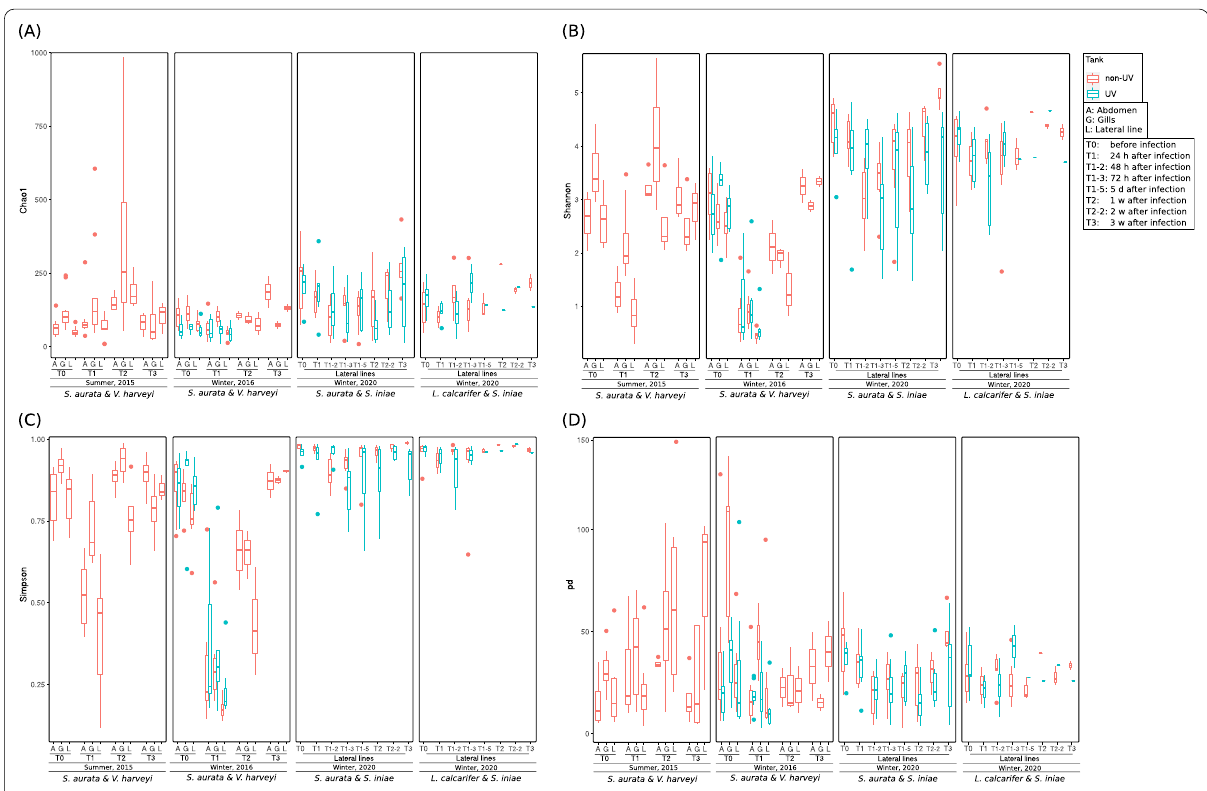
tional file 3: Table S5) show distinctly unique fish skin bacterial communities in fish from UV and non-UV tanks for S. aurata during both V. harveyi (Fig. 3b) and